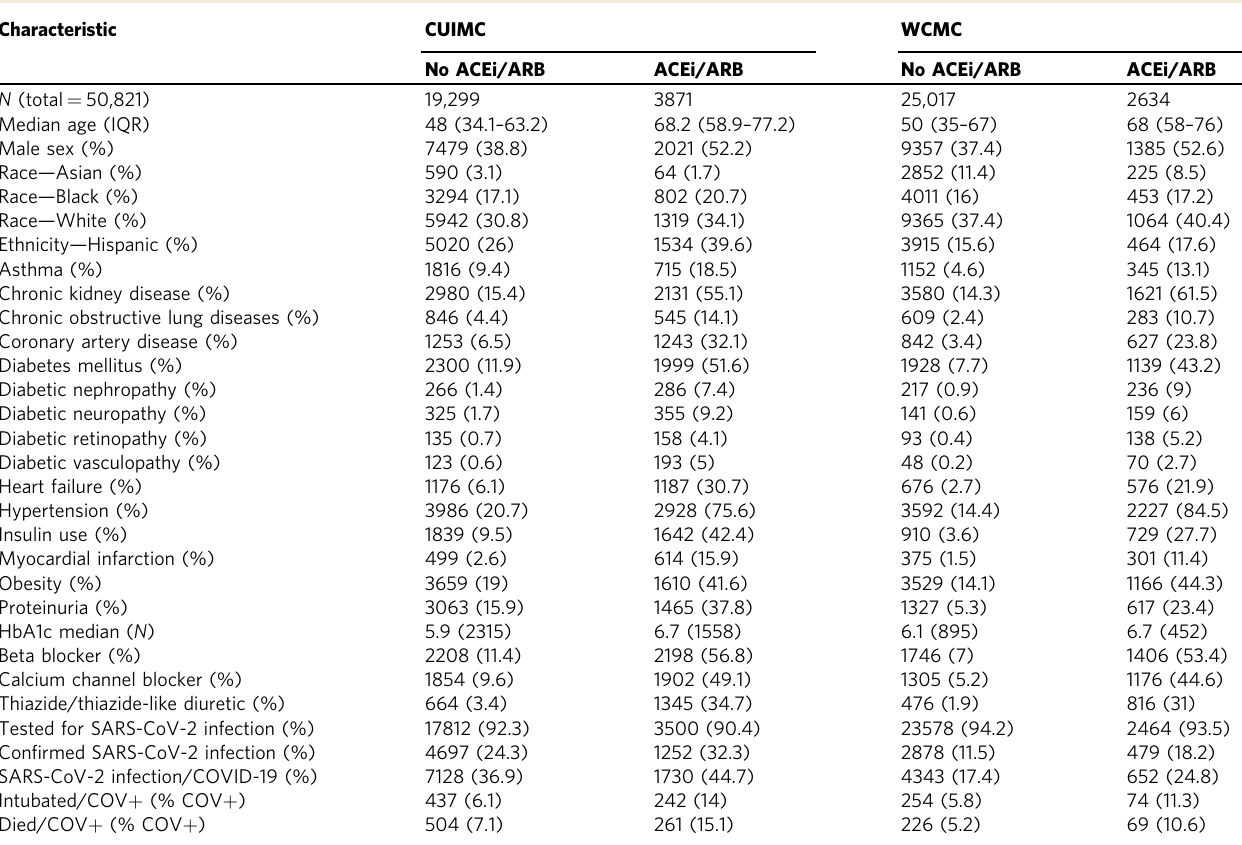
Table 1 ACEI/ARB characteristics.